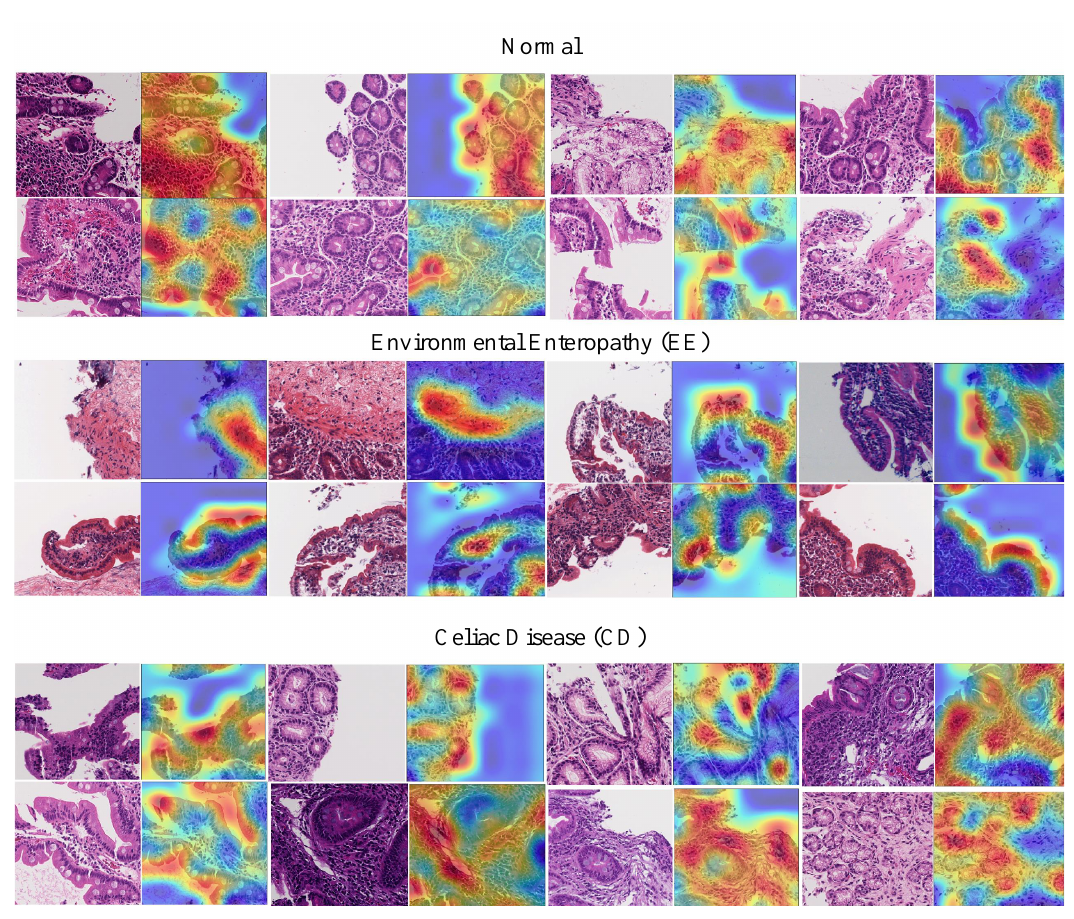
Figure 8. Grad-CAM results for showing feature